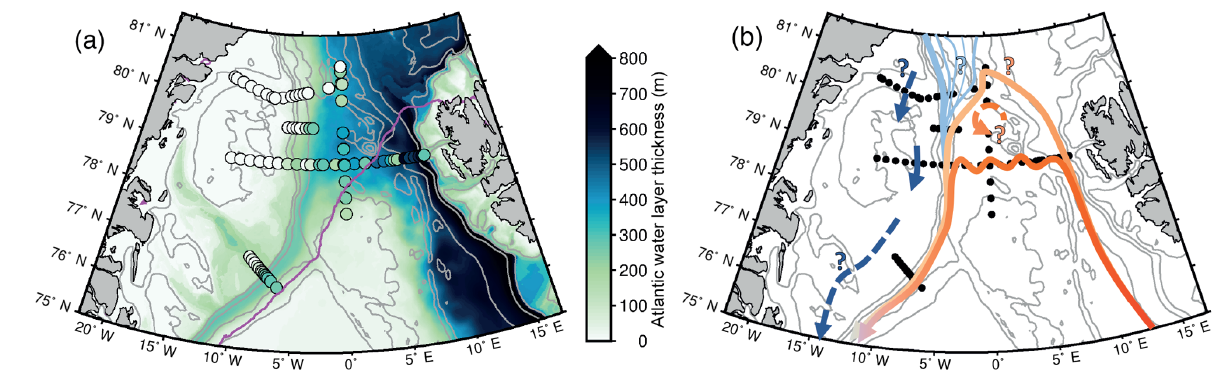
Figure 9. (a) AW-layer thickness given in metres. Shading shows the year-round 2000–2009 average from FESOM and coloured dots show the synoptic station data. Stations at which no AW was measured are shown in white. Thin grey lines represent bathymetry and magenta represents the modelled summer ice edge. (b) The updated circulation scheme is presented. Features we only speculate about are shown dashed and with a question